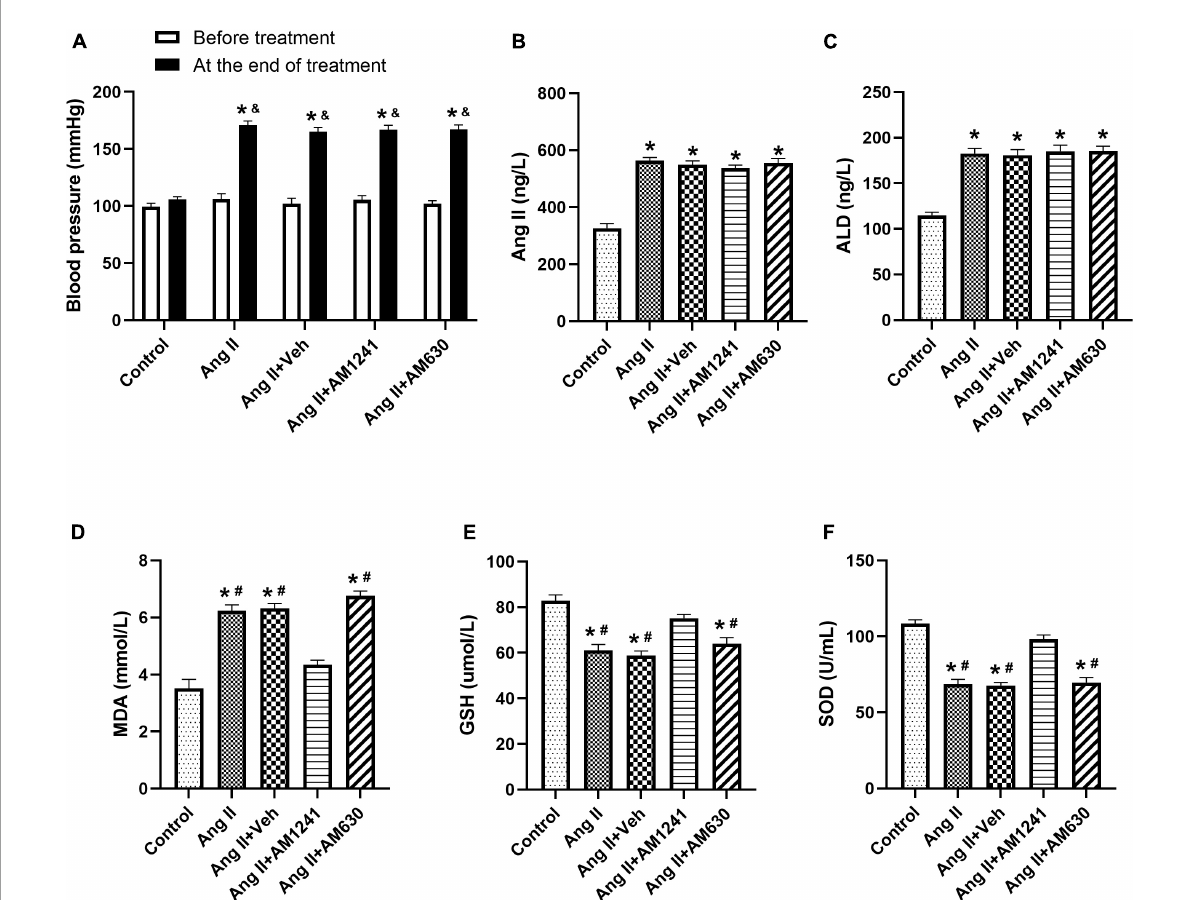
FIGURE1 Under Angiotensin II stimulation, the RAAS was activated, and blood pressure (BP) rose. Ang II (2,000 ng/kg/min) was subcutaneously infused into the mice for 21 days. In addition, solvent (0.1 ml), AM1241 (20 mg/kg), and AM630 (3 mg/kg) were administered intraperitoneally every day to the animals. Before the treatment, there were no significant differences in blood pressure (BP) among the five groups. After 21 days of different treatments, BP increased significantly in all groups except the control group (A) . The content of Angiotensin II (B) , aldosterone (ALD) (C) , malondialdehyde (MDA) (D) and glutathione (GSH) (E), and the enzyme activity of superoxide dismutase (SOD) (F) were determined by serological examination. The data represent the mean ± SEM. * P < 0.05 vs. control group. & p < 0.05 vs. before treatment. # P < 0.05 vs. Ang II + AM1241